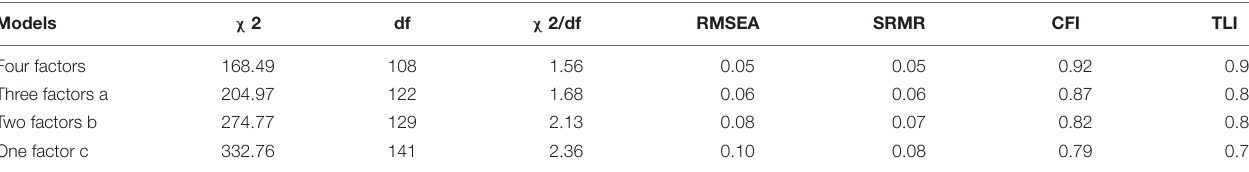
TABLE 2 | Confirmatory factor analysis